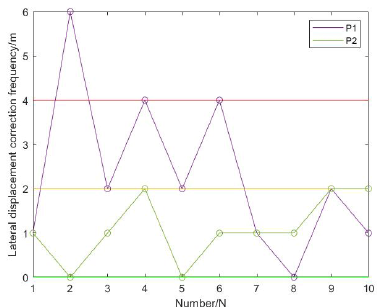
Figure 10. Lateral displacement correction frequency.